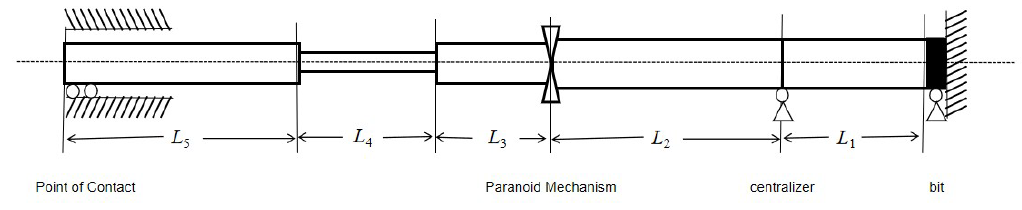
Figure 3. Model simplification and unit division.